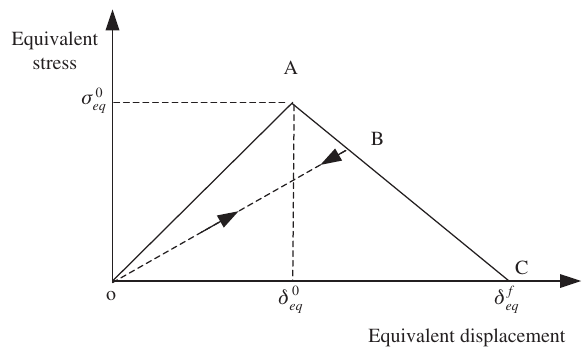
Figure 3: Damage evolution for progressive failure.